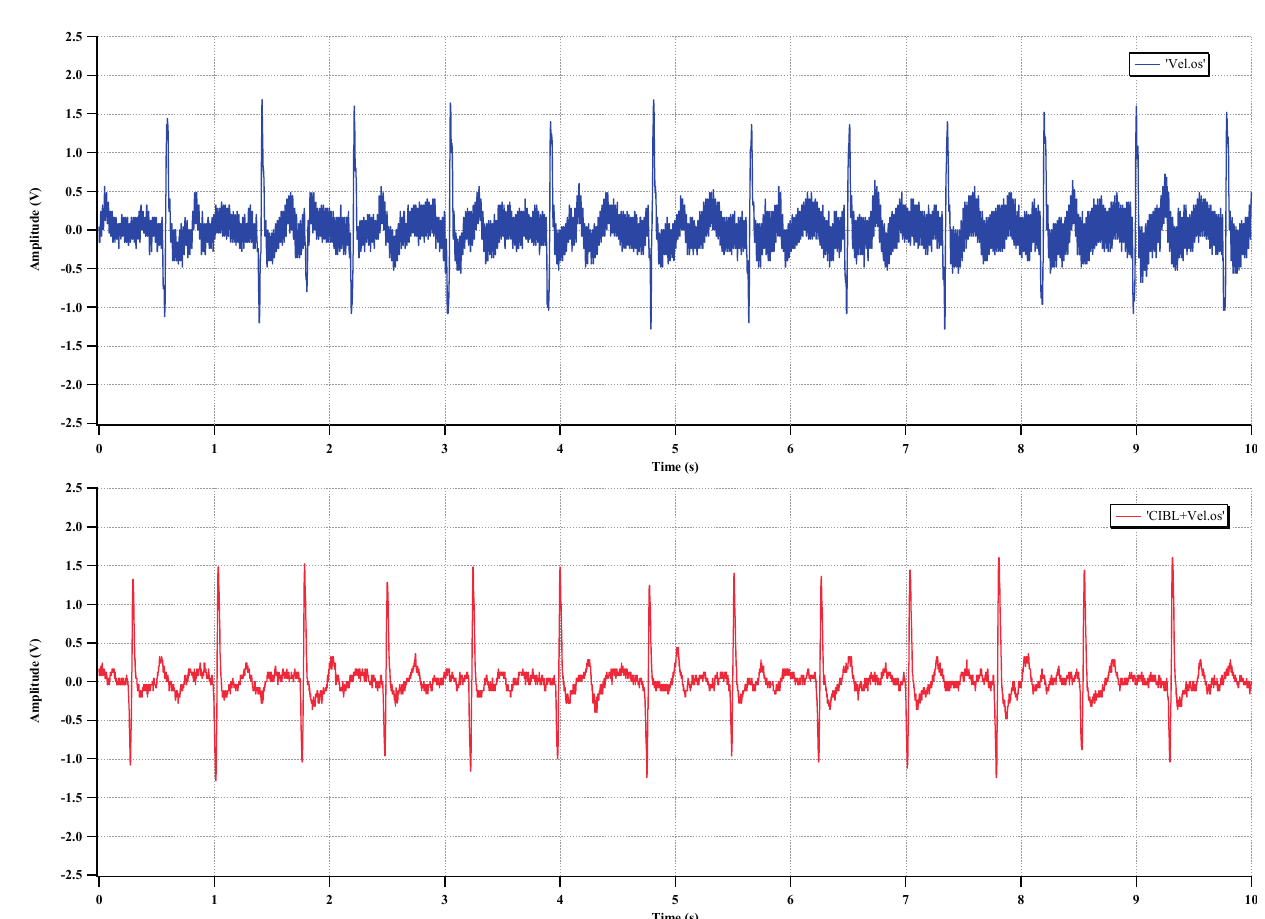
Figure 20. Measured ECG with RRL activation.